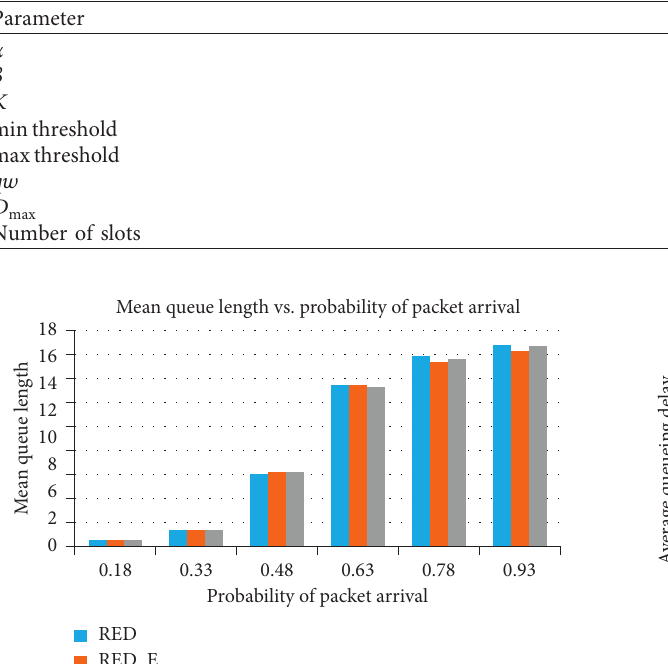
Figure 5: mql versus α .